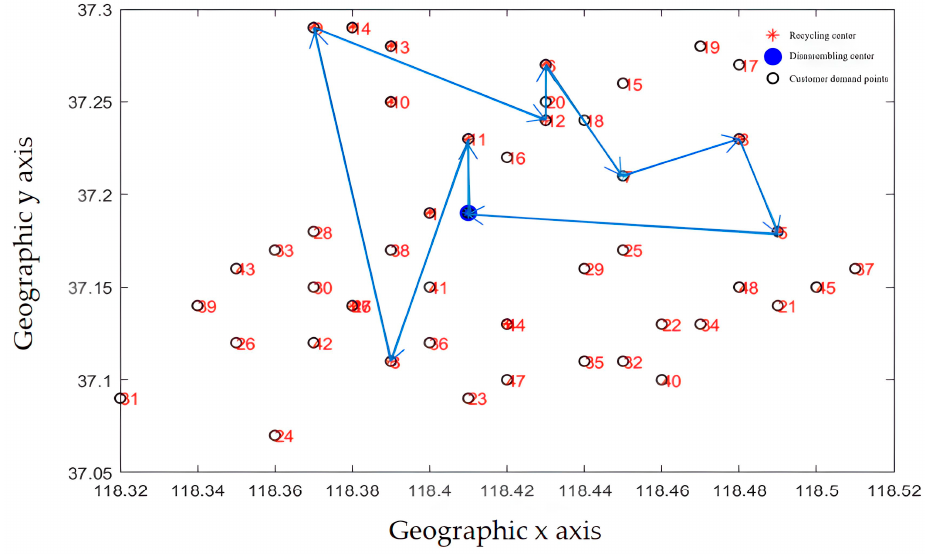
Figure 15. Delivery route before optimization (improved NSGA-II algorithm).